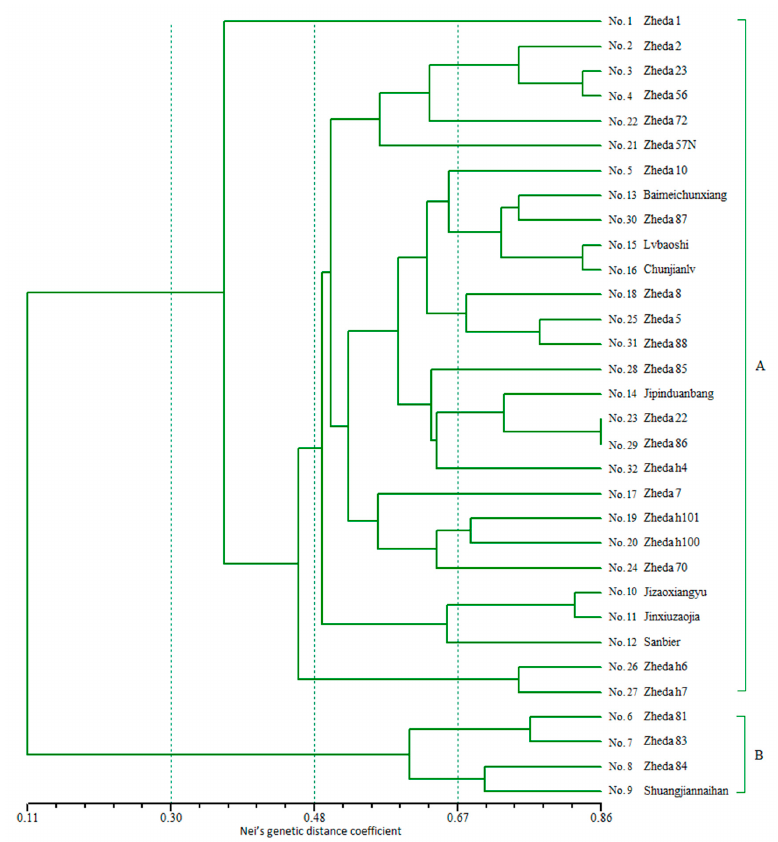
Figure 8. Evolutionary relationships of PCR products obtained with the SSR marker ZJULM 50 based on sequencing analysis. (Nos. 1–32, 32 accessions, detailed explanation can be seen in Table 7; the color of the branches is the same with the result of SSR-HRM group color in Figure 6E). Int. J. Mol. Sci. 2017 , 18 , 1942 According to these 19 group SSR-HRM genotype data (Table 5), dendrogram for 32 Luffa accessions were performed (Figure 9) based on Nei’s genetic distance coefficient [19], and then these